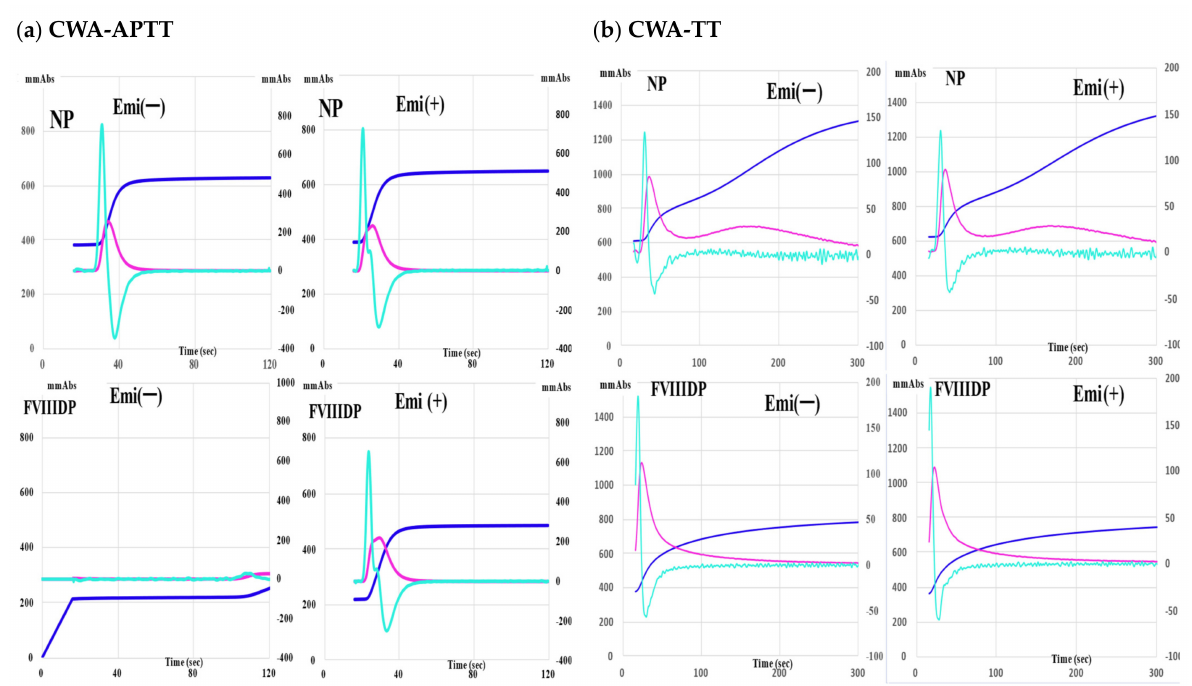
Figure 1. Effects of emicizumab (0.15 mg/mL) on the clot waveform analysis (CWA). ( a ) Activated partial thromboplastin time (APTT). ( b ) thrombin time (TT); upper, normal plasma (NP); lower, FVIII-deficient plasma (FVIIID); Emi, emicizumab; navy-blue, fibrin formation curve; pink curve, 1st derivative curve; light-blue curve, 2nd derivative curve. All assays were performed more than three times to confirm the reproducibility.